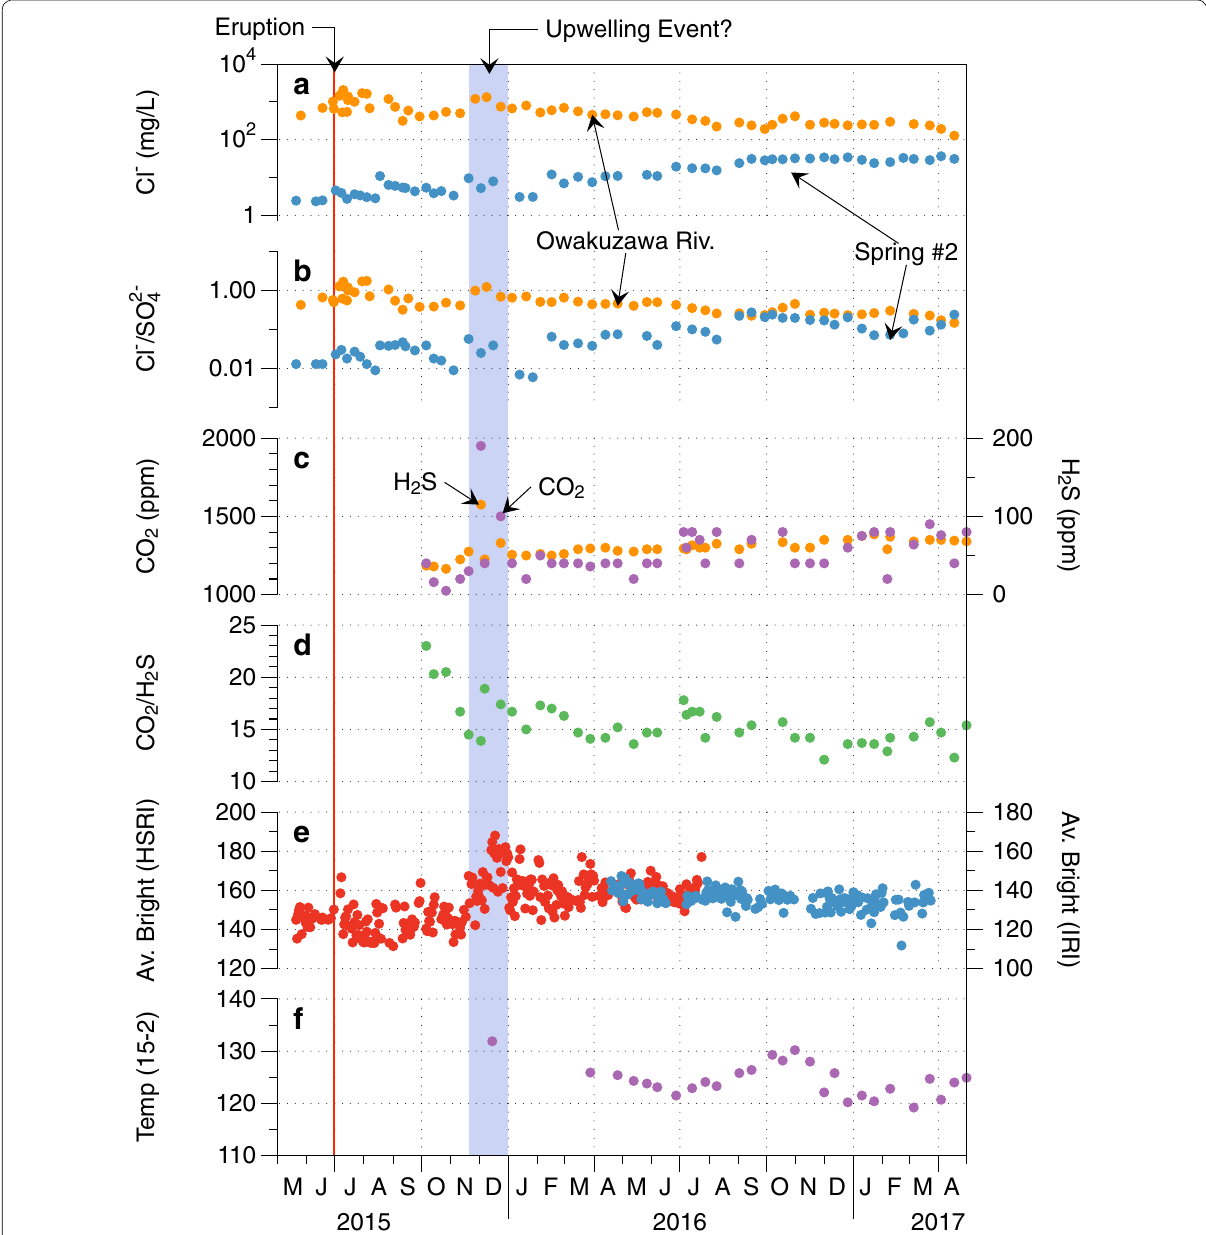
Fig. 18 Changes of water and gas chemistries, steam emission and temperature of steam from newly formed fumaroles at Owakudani before and after the eruption. a Cl − content (ppm) and b Cl − /SO 42 − ratio of Owakuzawa River (Loc. 1) and natural spring #2 (Loc. 2). c CO 2 content (ppm) and d CO 2 /H 2 S ratio of volcanic gas seeping to the surface (Loc. 3). e Average brightness of digital images of eruption area. Since steam is white, average brightness of image of eruption area is expected to increase as a function of steam emission. Red dots imply value for images taken by time-lapse cameras installed by HSRI and blue dots for webcam installed by IRI. f Temperature of 15-2 fumarole. Sampling locations are shown in Fig.